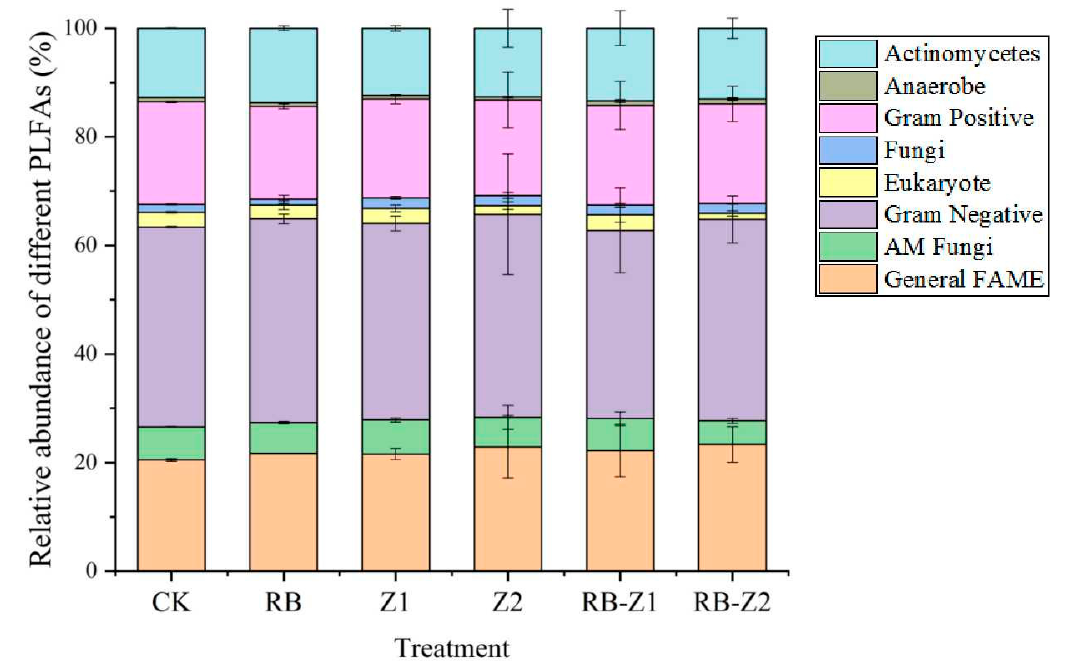
Figure 4. Relative abundance of different phospholipids fatty acids in the rhizosphere soil. The data are means ± SD, n = 3.